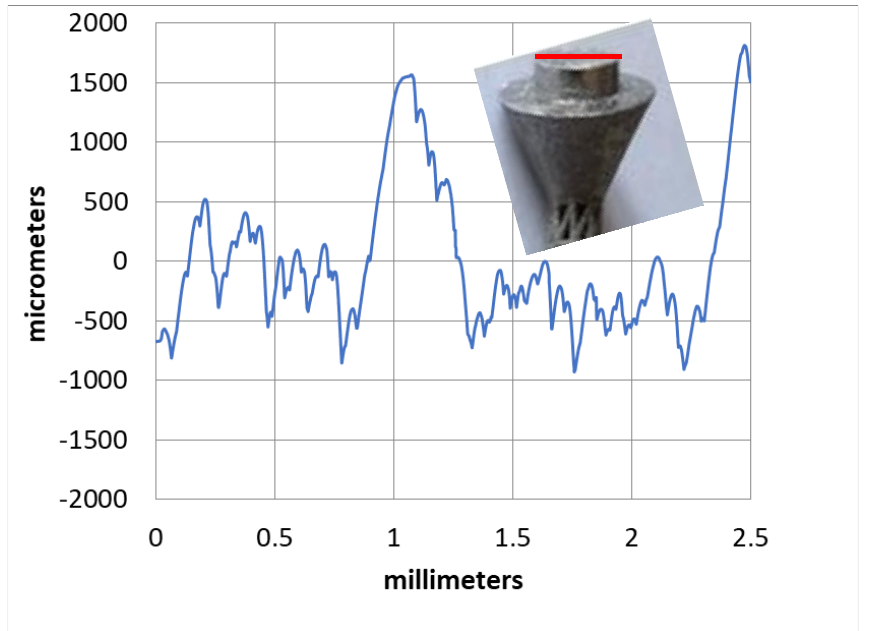
Figure 11. Typical surface roughness profile through the highlighted line (in red) at the head of the implant.